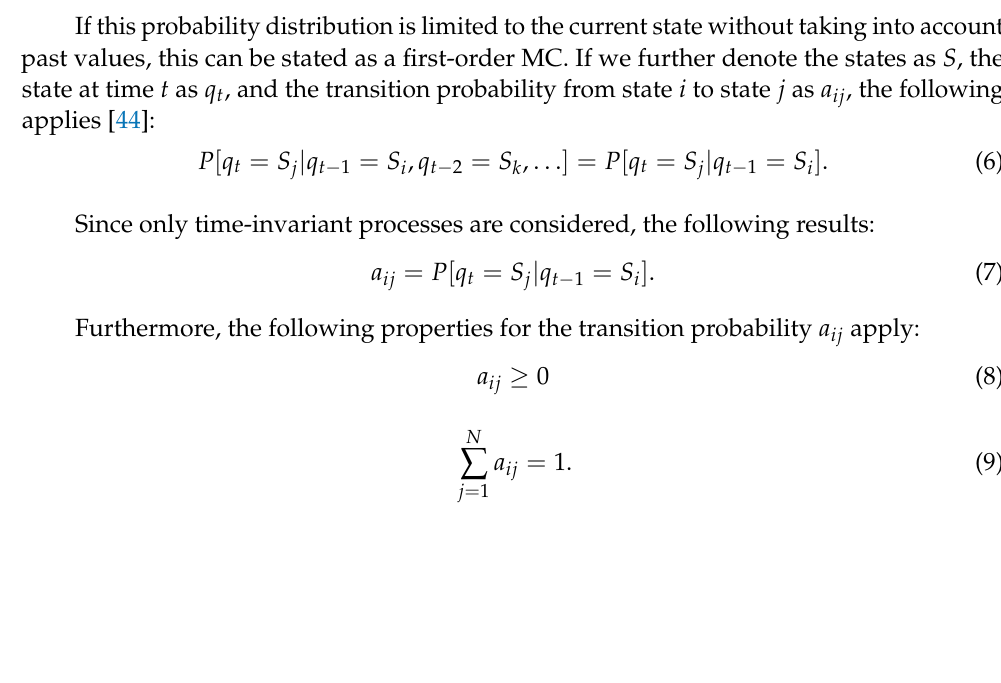
Figure 1. Proposed generic model predictive control